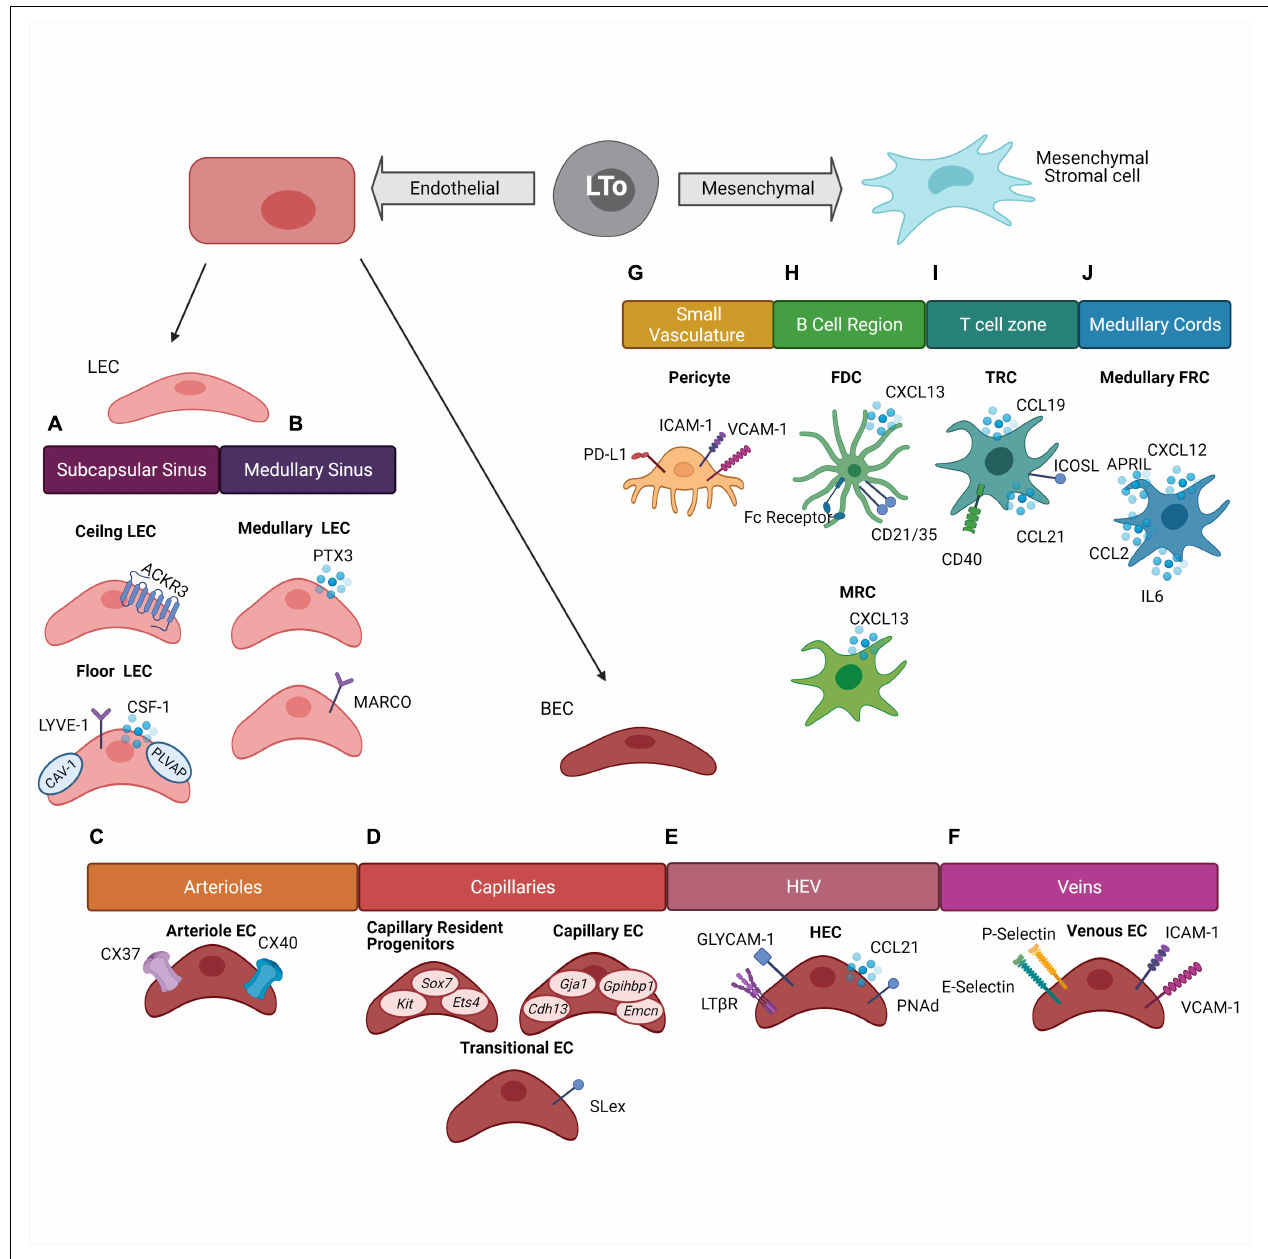
FIGURE 1 | Stromal cell heterogeneity within the lymph node. Stromal cells within the lymph node are derived from two cell lineages which originated from the Lymphoid Tissue organizer (LTo) cells: endothelial lineage and mesenchymal lineage. (A) Subcapsular sinus lymphatic endothelial cells (LEC) are divided into two groups. Ceiling LEC expressing Atypical Chemokine Receptor 3 (ACKR3) and floor LEC expressing Colony Stimulating Factor 1 (CSF-1), Lymphatic Vessel Endothelial Receptor 1 (LYVE-1), Caveolin-1 (CAV-1), and Plasmalemma Vesicle Associated Protein (PLVAP). (B) Medullary sinus LEC are divided into two groups based off of Pentraxin (PTX3) or Macrophage Receptor With Collagenous Structure (MARCO) expression. (C) Arterial endothelial cells (EC) express Connexin 37 (CX37) and Connexin 40 (CX40). (D) Capillary BEC are divided into three groups. Capillary resident progenitors express Kit , Sox7 , and Ets4 , Capillary EC express Cdh13, Gja1, Gpihbp1, and Emcn, and Transitional EC express Sialyl Lewis X (SLex). (E) High endothelial venules (HEV) are composed of high endothelial cells (HEC) and express Glycosylation-Dependent Cell Adhesion Molecule-1 (GLYCAM-1), Lymphotoxin Beta Receptor (LT β R), Chemokine Ligand 21 (CCL21), and Peripheral Lymph Node Addressin (PNAd). (F) Veins are composed of Venous EC which express E-selectins, P-selectins, Intercellular Adhesion Molecule 1 (ICAM-1), and Vascular Cell Adhesion Molecule 1 (VCAM-1). (G) Small vasculature is surrounded by pericytes which express Programmed Death-Ligand 1 (PD-L1), ICAM-1, and VCAM-1. (H) The B cell region is comprised of Follicular Dendritic Cells (FDC) which express Fc-Receptor, CD21/CD35 complex, and CXCL13. Marginal reticular cells express CXCL13. (I) The T cell zone is composed of T cell zone reticular cells expressing CD40, CCL21, and CCL19, and Inducible T Cell Costimulatory Ligand (ICOSL). (J) The medullar cords are comprised of Medullary Fibroblast Reticular Cells (FRC) which express CXCL12, CCL2, IL-6, and A Proliferation-Inducing Ligand (APRIL).